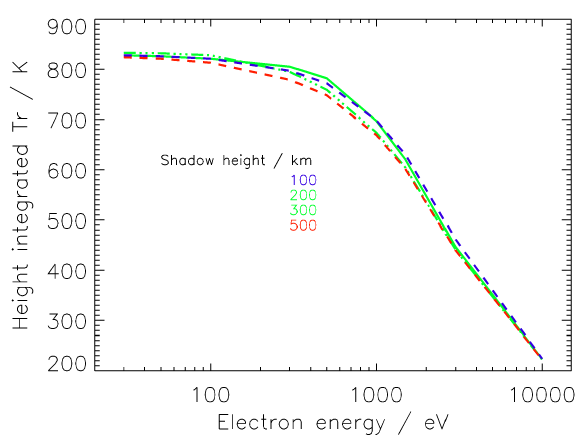
Fig. 10. Height integrated rotational temperature profiles as a func- tion of primary electron energy and shadow